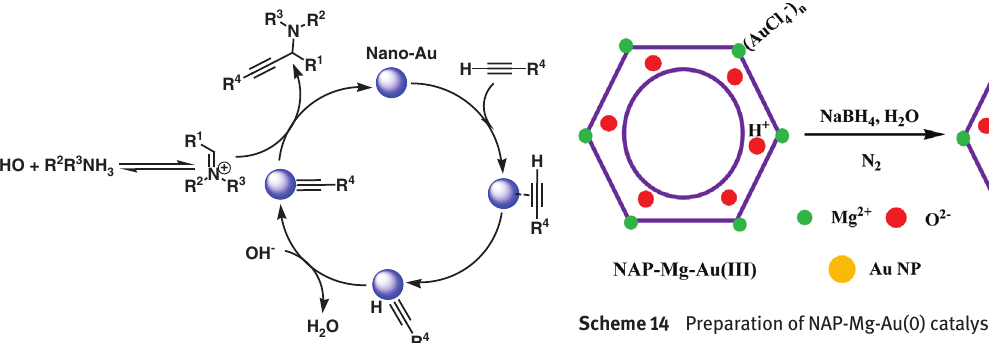
Figure 6 Proposed mechanism of Au nanoparticle-catalyzed A 3 -coupling of aldehyde, amine, and alkyne. Redrawn from [65].